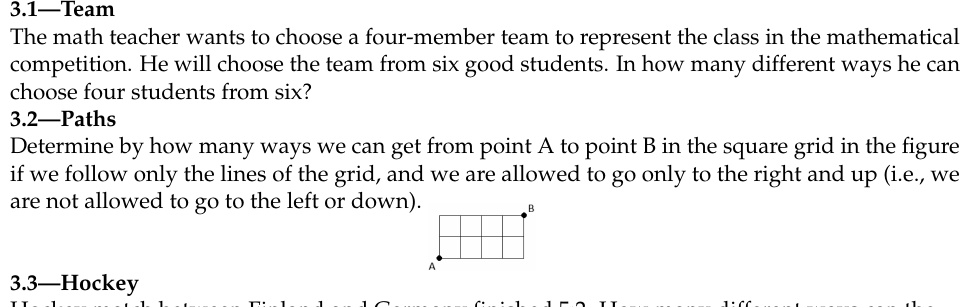
Table 2. Combinatorial MSTs for Sessions 3 and